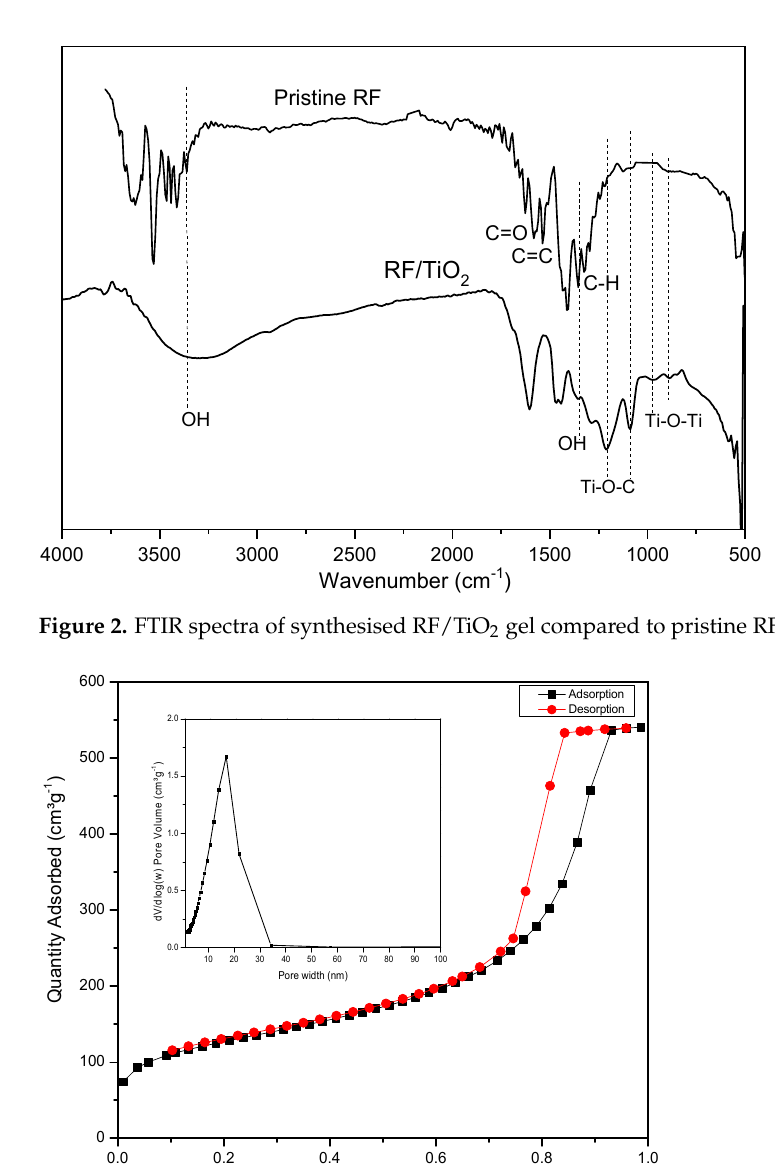
pH Figure 4. Effect of pH on the adsorption of MB dye by RF/TiO 2 gel.